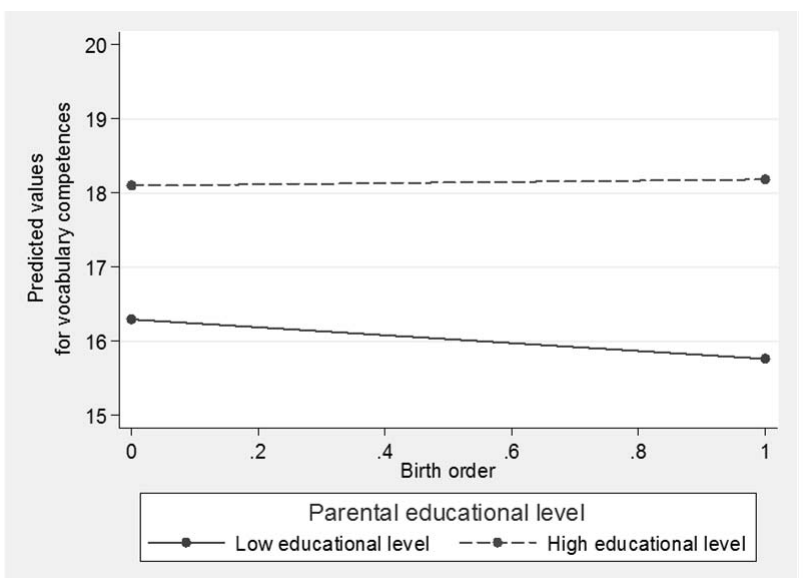
Figure 2 : Interaction effect of birth order and families’ educational